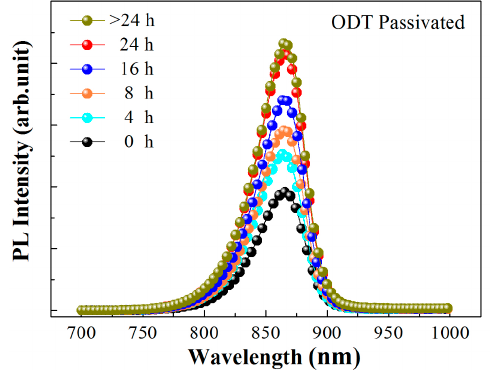
Figure 3. PL spectra of GaAs (100) surface after ODT passivation for different times.